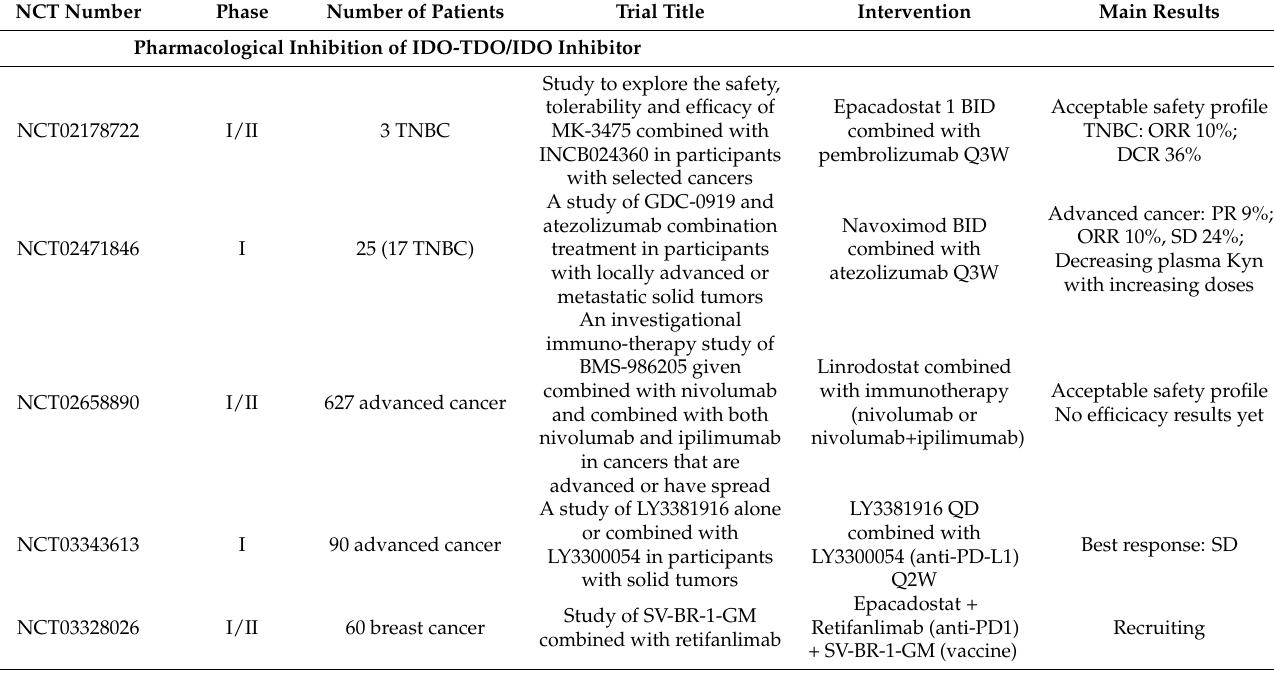
Table 2. Clinical trials targeting the IDO/TDO-Kyn-AhR signaling. Past and recruiting trials, adapted from Peyraud et al. [82] IDO: indoleamine 2,3-dioxygenase; TDO: Tryptophan